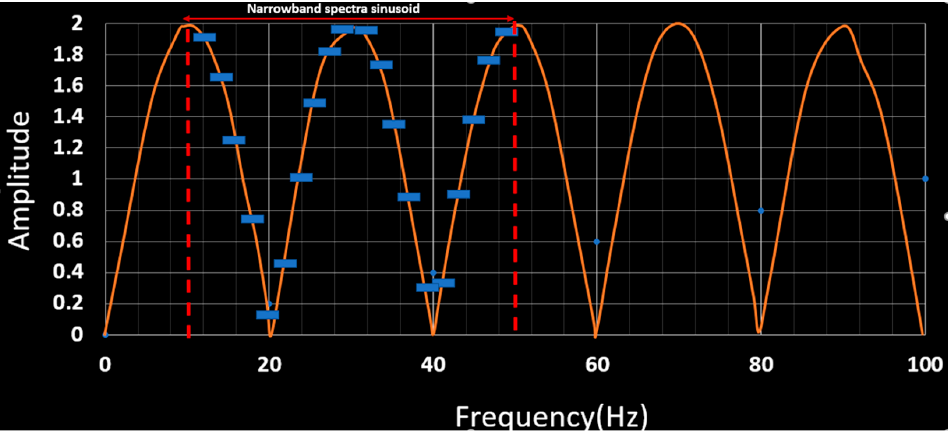
Figure 9. Reflectivity amplitude spectrum for a simple layer of 50 ms thickness, with equal and opposite reflection coefficients of unit amplitude at the top and base. Modified after [19].